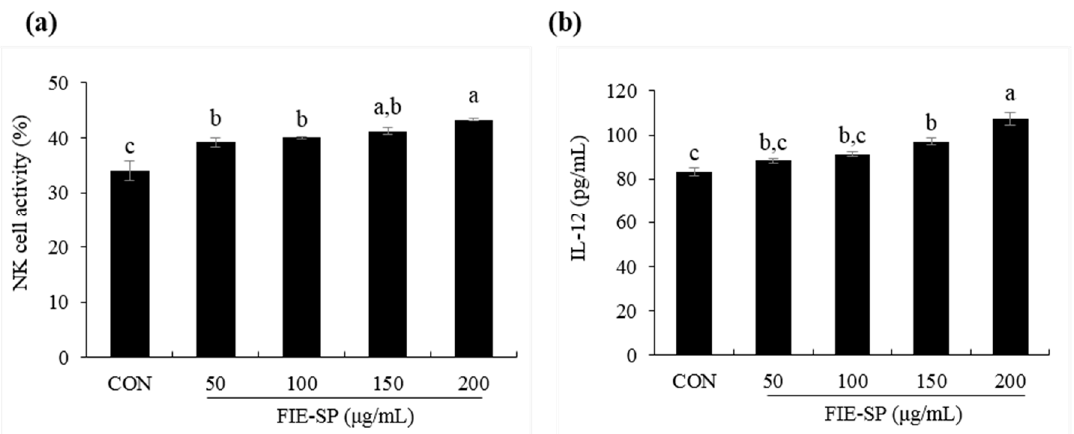
Figure 5. Natural killer (NK) cell activity following FIE-SP treatment of splenocytes. ( a ) Various concentrations of NK cell activities of splenocytes. ( b ) IL-12 cytokine secretion in FIE-SP-treated splenocytes. Data are expressed as the mean ±S.D. Different letters in a column indicate statistical differences based upon Duncan’s multiple range test ( p < 0.05).